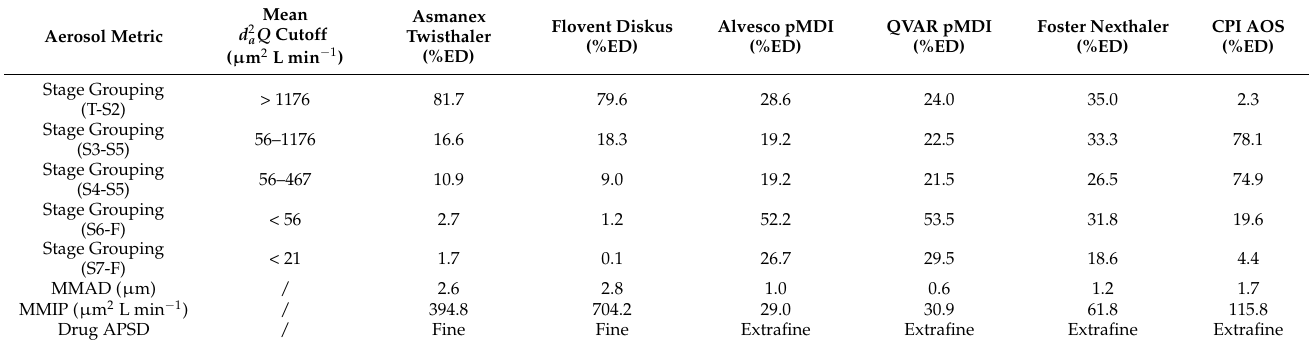
Table 3. Comparison of the stage distributions of various ICS formulations in an NGI [38,70,71,76]. Aerosol